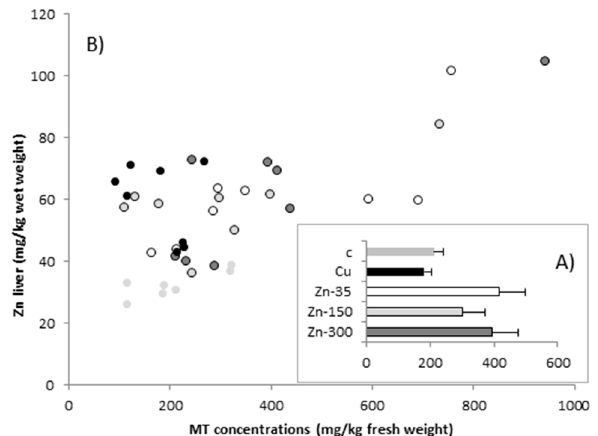
Figure 2. Scatter plot showing ( A ) metallothionein (MT) concentrations (expressed as mean ± SEM) and ( B ) the relationship between MT and Zn concentrations (mg/kg fresh weight) in the liver of sheep at the end of the study, for the five experimental groups: C, control (no treatment); Cu, 450 mg Cu/kg dry matter (DM); Zn-35, 450 mg Cu + 35 mg Zn/kg DM; Zn-150, 450 mg Cu + 150 mg Zn/kg DM; and Zn-300, 450 mg Cu + 300 mg Zn/kg DM.